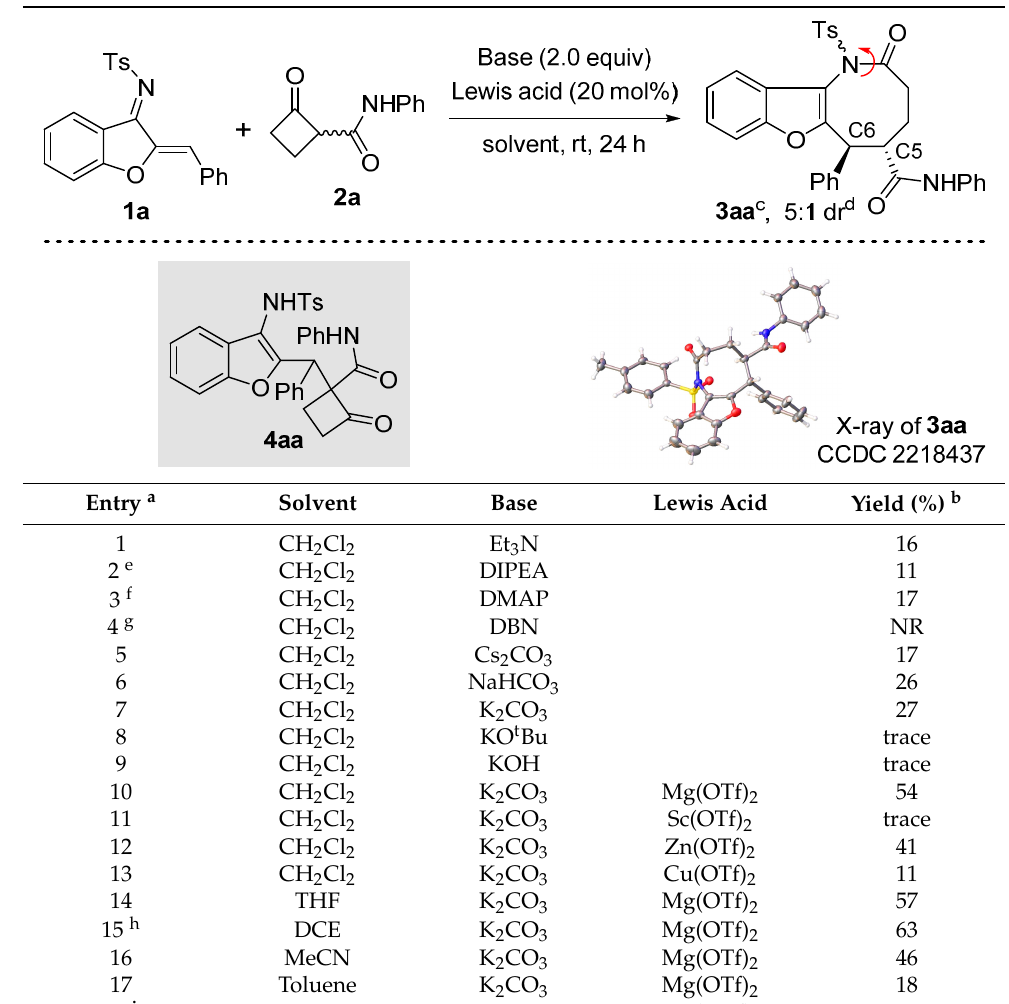
CH 2 Cl 2 NaHCO